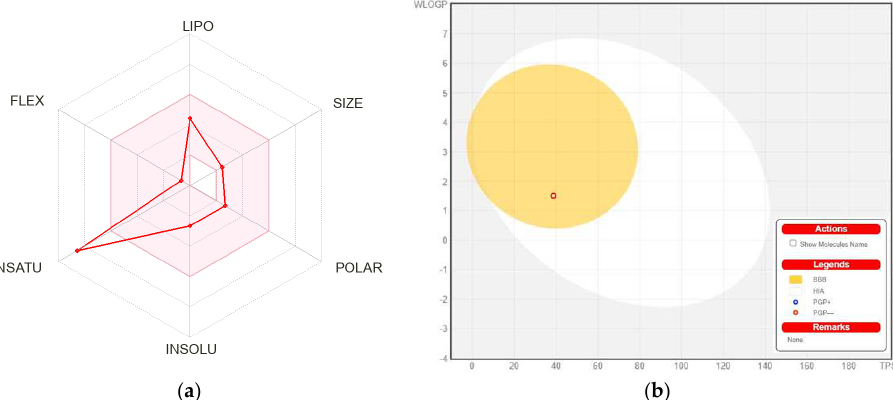
Figure 9. ( a ) Bioavailability radar chart for isolated flavone. The pink zone represents the physico- chemical space for oral bioavailability, and the red line represents the oral bioavailability properties. ( b ) Predicted BOILED-Egg plot from swiss ADME online web tool for MBO.